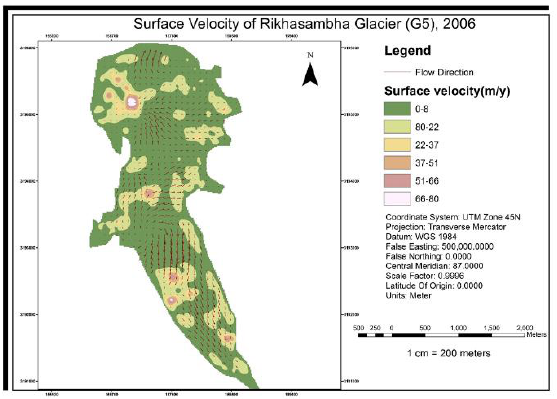
Table 3. Summary of Mean Thickness and maximum thickness of Glacier.